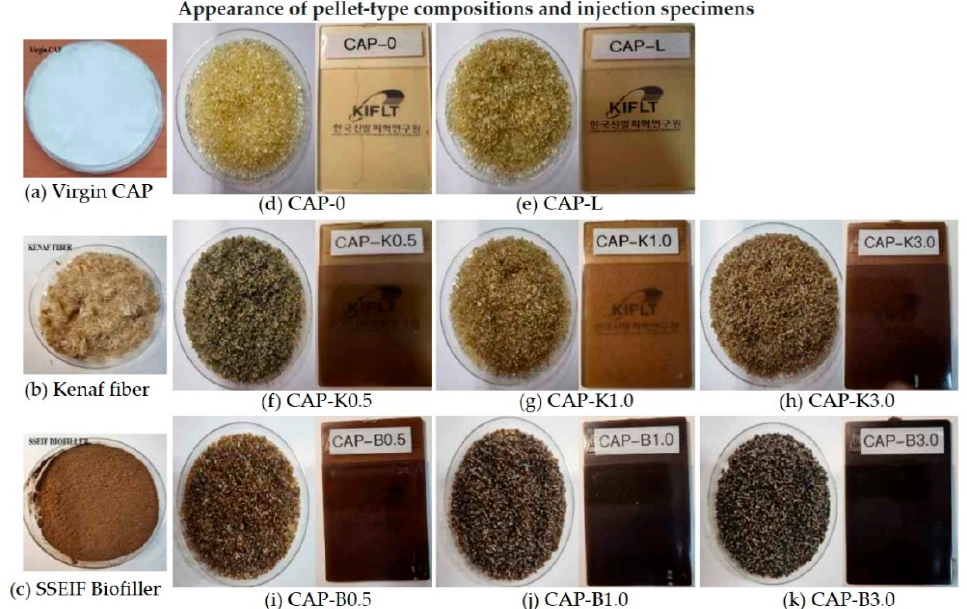
Figure 13. Appearance of the raw materials and biocomposite: ( a )Virgin CAP; ( b ) Kenaf fiber; ( c ) SSEIF biofiller ( d ) CAP-0; ( e ) CAP-L; ( f ) CAP-K0.5; ( g ) CAP-K1.0; ( h ) CAP-K3.0; ( i ) CAP-B0.5; ( j ) CAP-B1.0; and ( k ) CAP-B3.0.